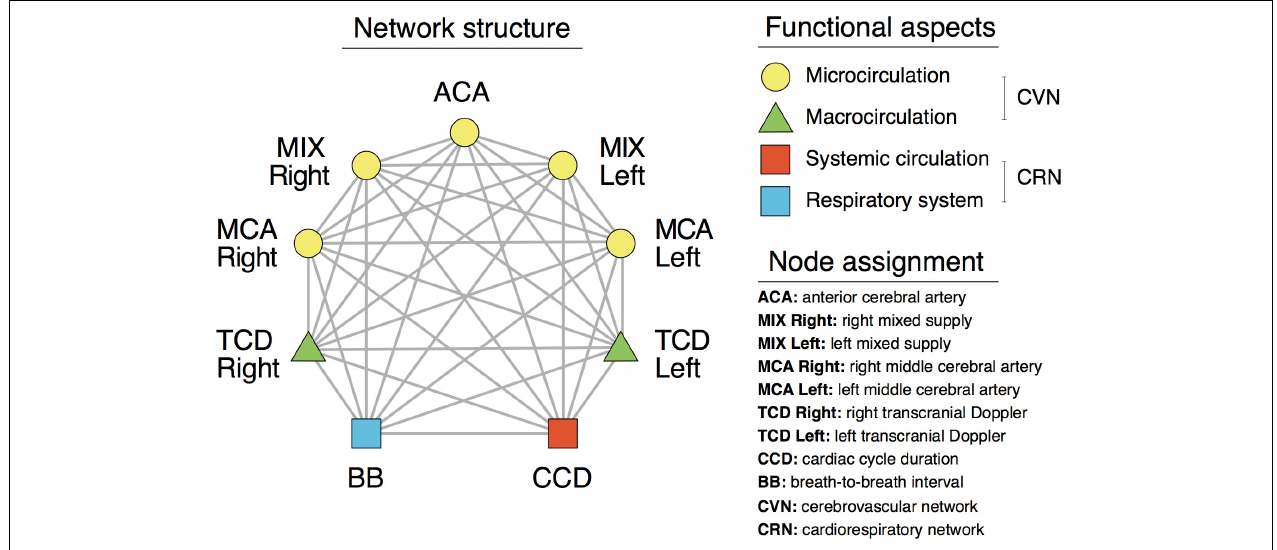
FIGURE 2 | Structural and functional aspects of the cardiorespiratory and cerebrovascular networks.